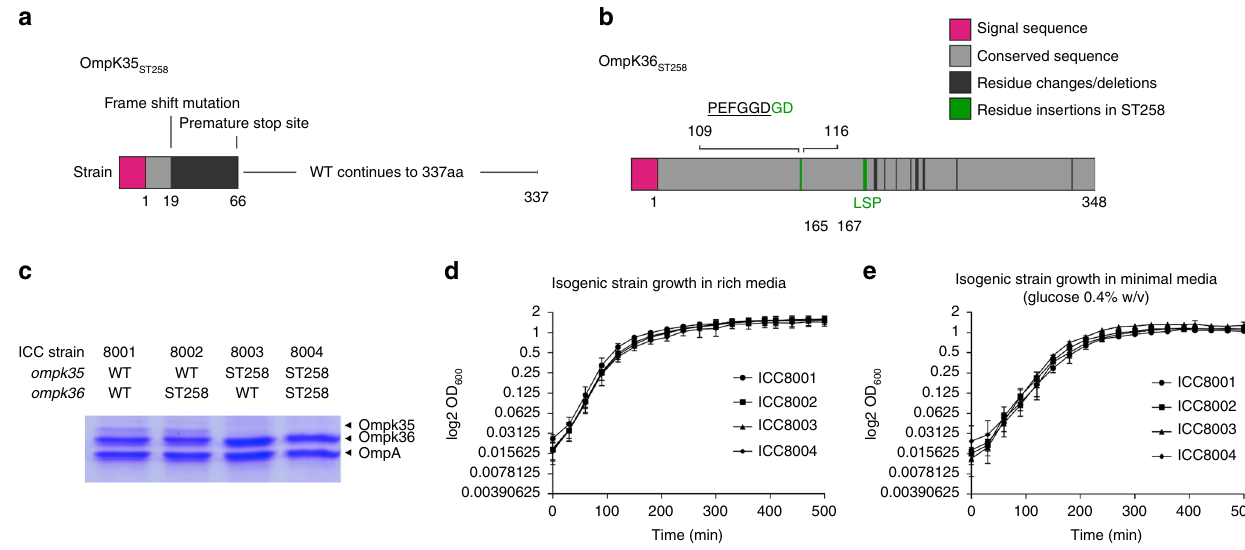
Fig. 1 OmpK35 ST258 and OmpK36 ST258 porin variants do not impact on growth in vitro. a The OmpK35 ST258 frame-shift mutation results in a premature TGA stop codon. Sequence conservation with OmpK35 WT is lost within the fi rst β -strand resulting in a truncated protein. b OmpK36 sequences share 95% identity, with two insertions (GD in loop 3 and LSP in loop 4) in OmpK36 ST258 (highlighted in green). The underlined PEFGGD is a conserved loop 3 motif in OmpK36 porins. c Outer membrane preparations demonstrate a loss of OmpK35 in ICC8003 and ICC8004. OmpK36 WT (ICC8001 and ICC8003) and OmpK36 ST258 (ICC8002 and ICC8004) are present in similar abundance in isogenic strains. d , e Growth, measured by OD 600 , is not affected by the introduction of ST258 porins into ICC8001 in rich (Luria Bertani) media ( d ) or minimal (M9) media ( e ) with glucose as the sole carbon source ( n = 3 repeats, error bars =